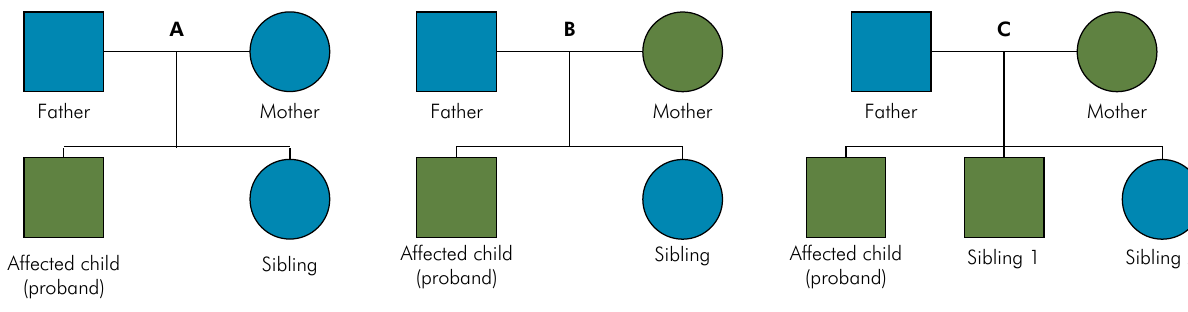
Figure 1. Pedigrees of proband families. (A) Only one affected member (proband); (B) Two affected members (proband and mother); (C) Three affected members (proband, mother and one